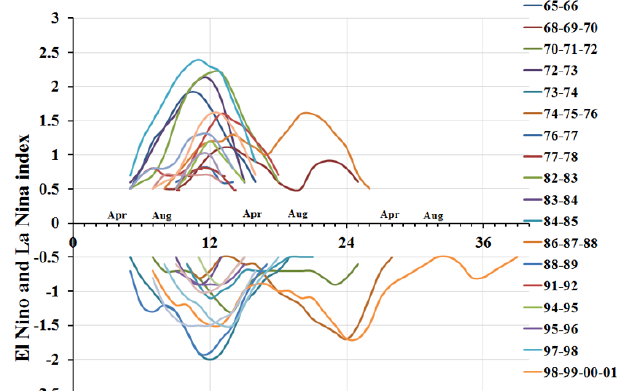
Fig. 1. El Niño and La Niña timing.